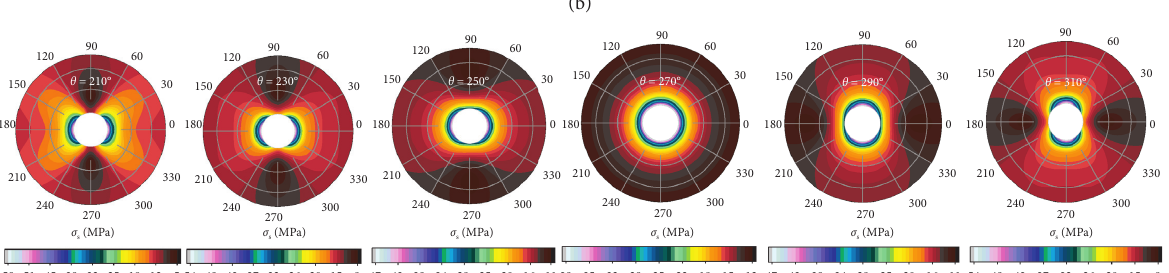
v -type stress field. (b) σ H -type